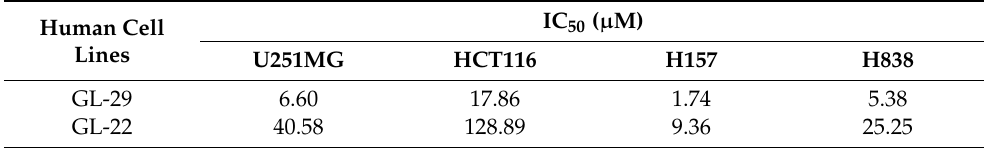
Figure 5. Fluorescence micrographs of DAPI/PI staining ( a ) S. aureus (ATCC CRM 6538 ) and ( b ) E. coli (ATCC CRM 8739) treated with GL-29 and GL-22 at different concentrations. N and P represent the negative control and positive control, respectively. Melittin (16 μ M) was employed as a positive control. The negative control was bacterial cell suspension with no treatment. Table 4. The IC 50 values of GL-29 and GL-22 against different cell